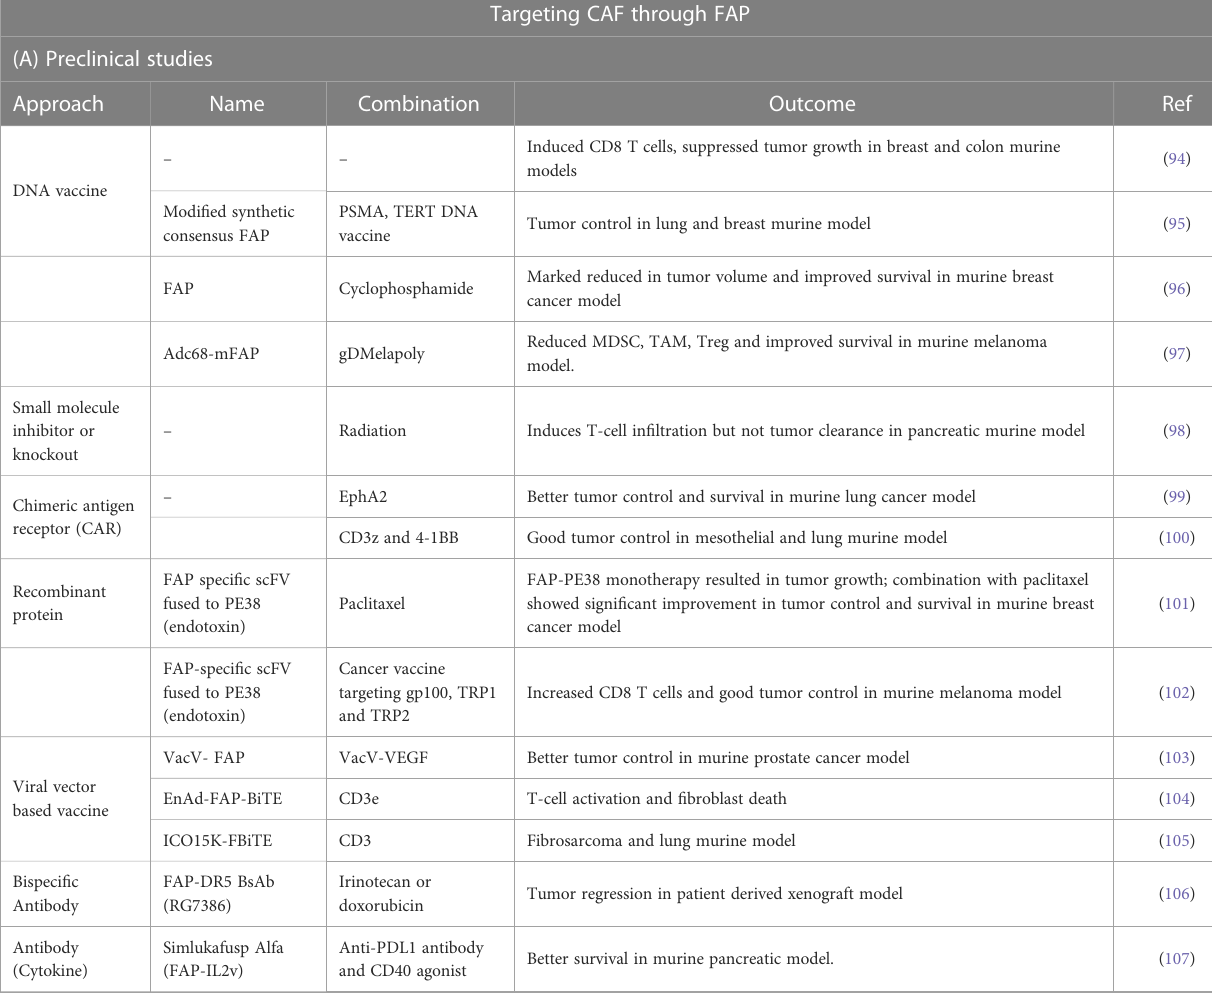
TABLE 1 Available anti-CAF therapies through targeting fi broblast activating